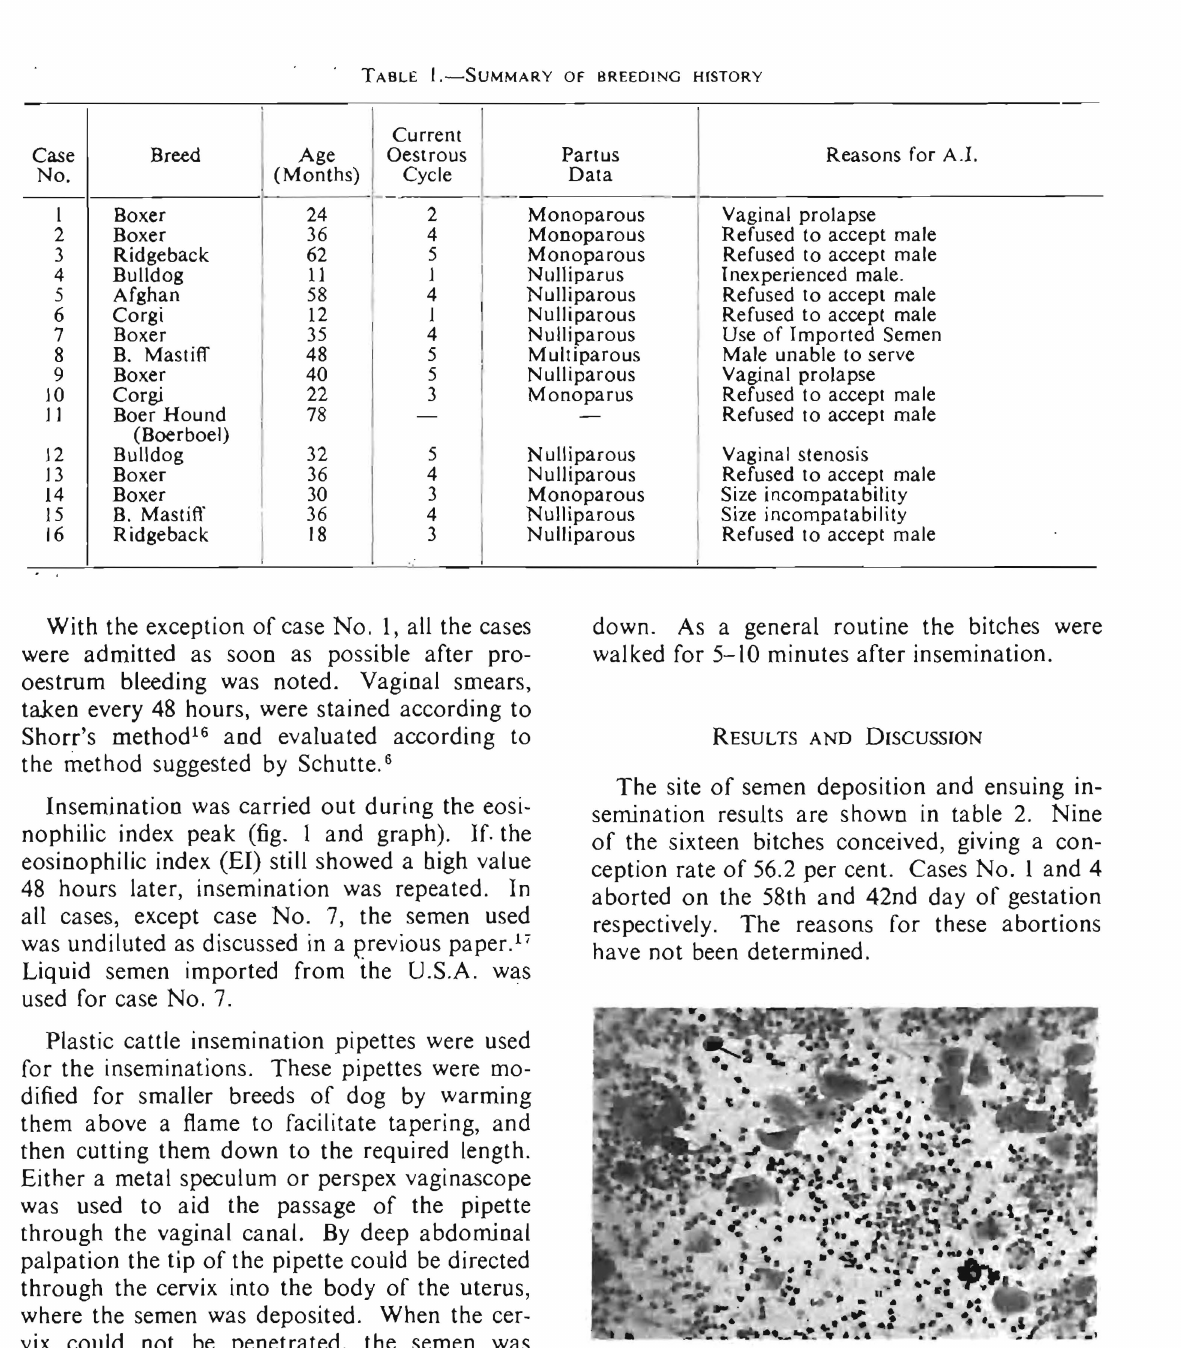
Fig. 2 .. - An abnormal met'1estrum smear depicting the presence of a high superficial cell index. A few parabasal cells (a; are also shown. Note the high concentration of